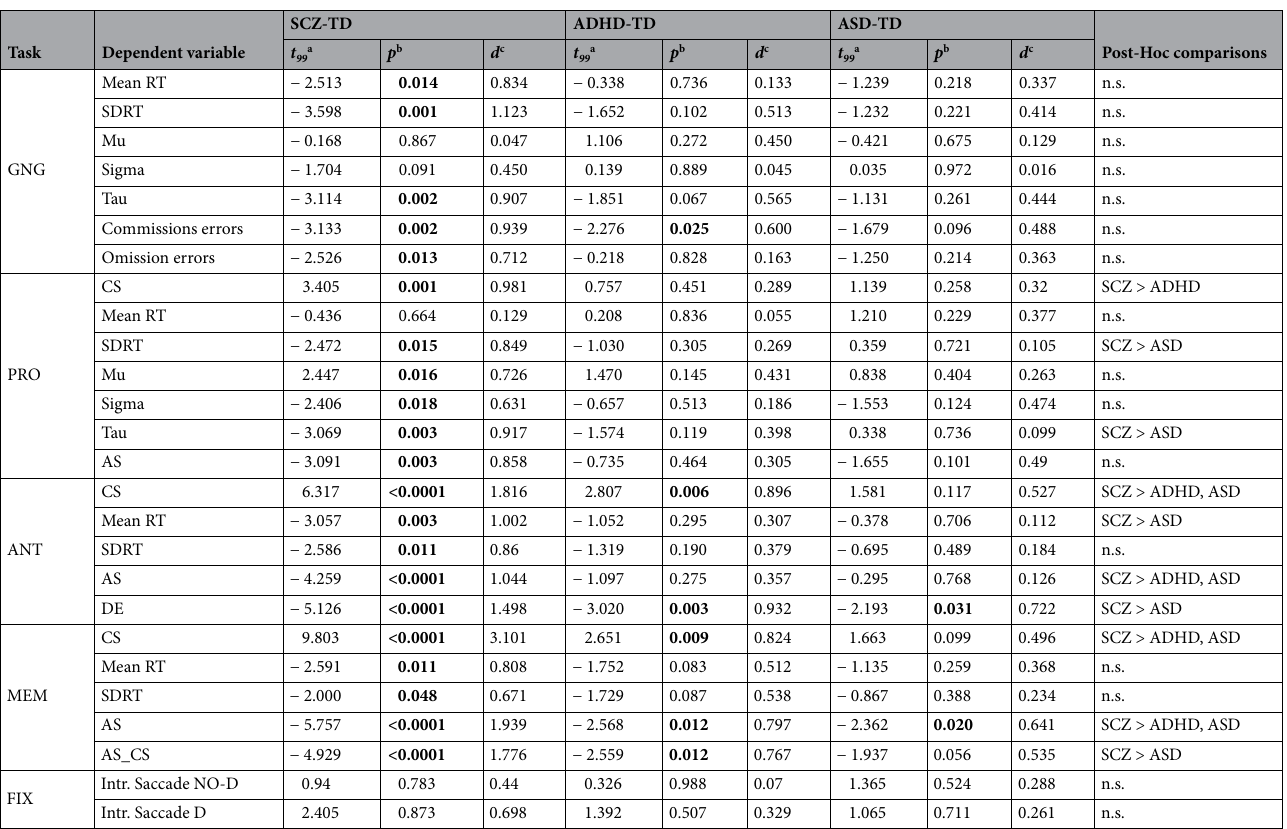
Table 4. Planned contrasts between TD and clinical groups, Post-Hoc comparisons between clinical groups. Mean RT mean response time, SDRT standard deviation of response time, CS correct responses, AS